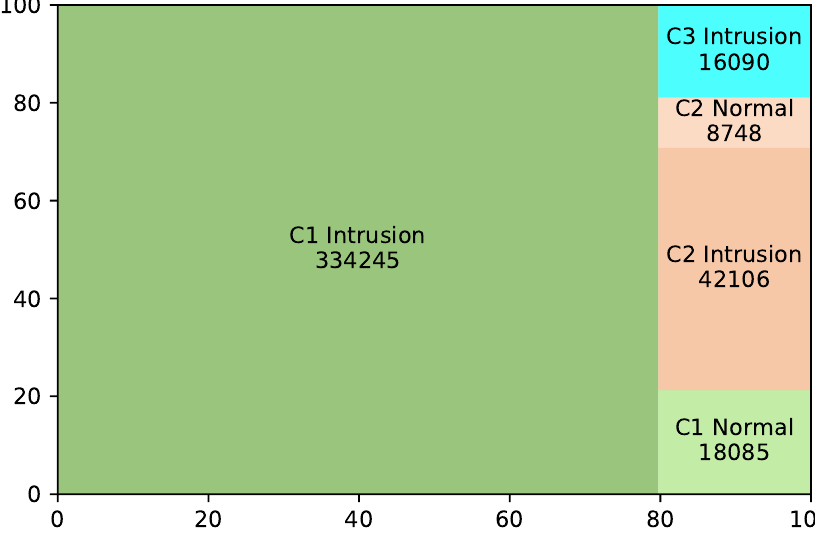
Figure 6. Distribution of instances before reduction.